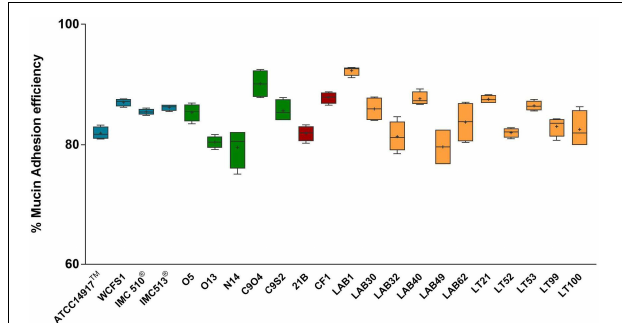
FIGURE 5 | Mucin adhesion efficiency of Lb. plantarum strains. Box and whisker plots with median, 25–75th percentiles, range and mean as “ + ” p < 0.0001 versus control.